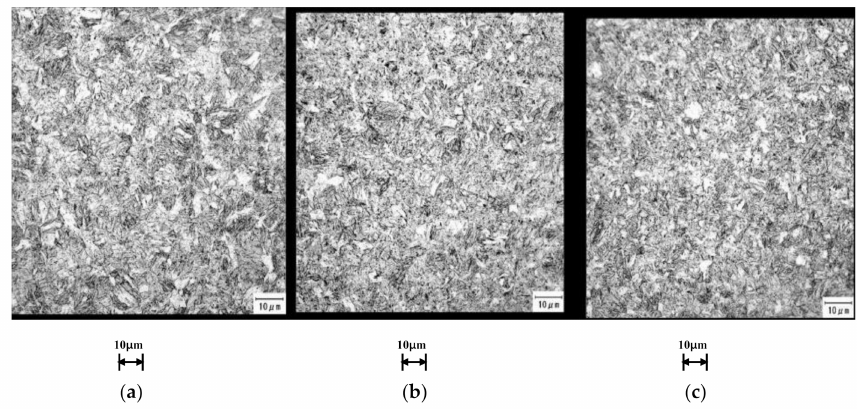
Figure 7. Microstructure of product by 3DQ (40 mm × 40 mm and thickness 1.8 mm): ( a ) 0.2 mm from outer surface, ( b ) thickness center, and ( c ) 0.2 mm from inner surface.